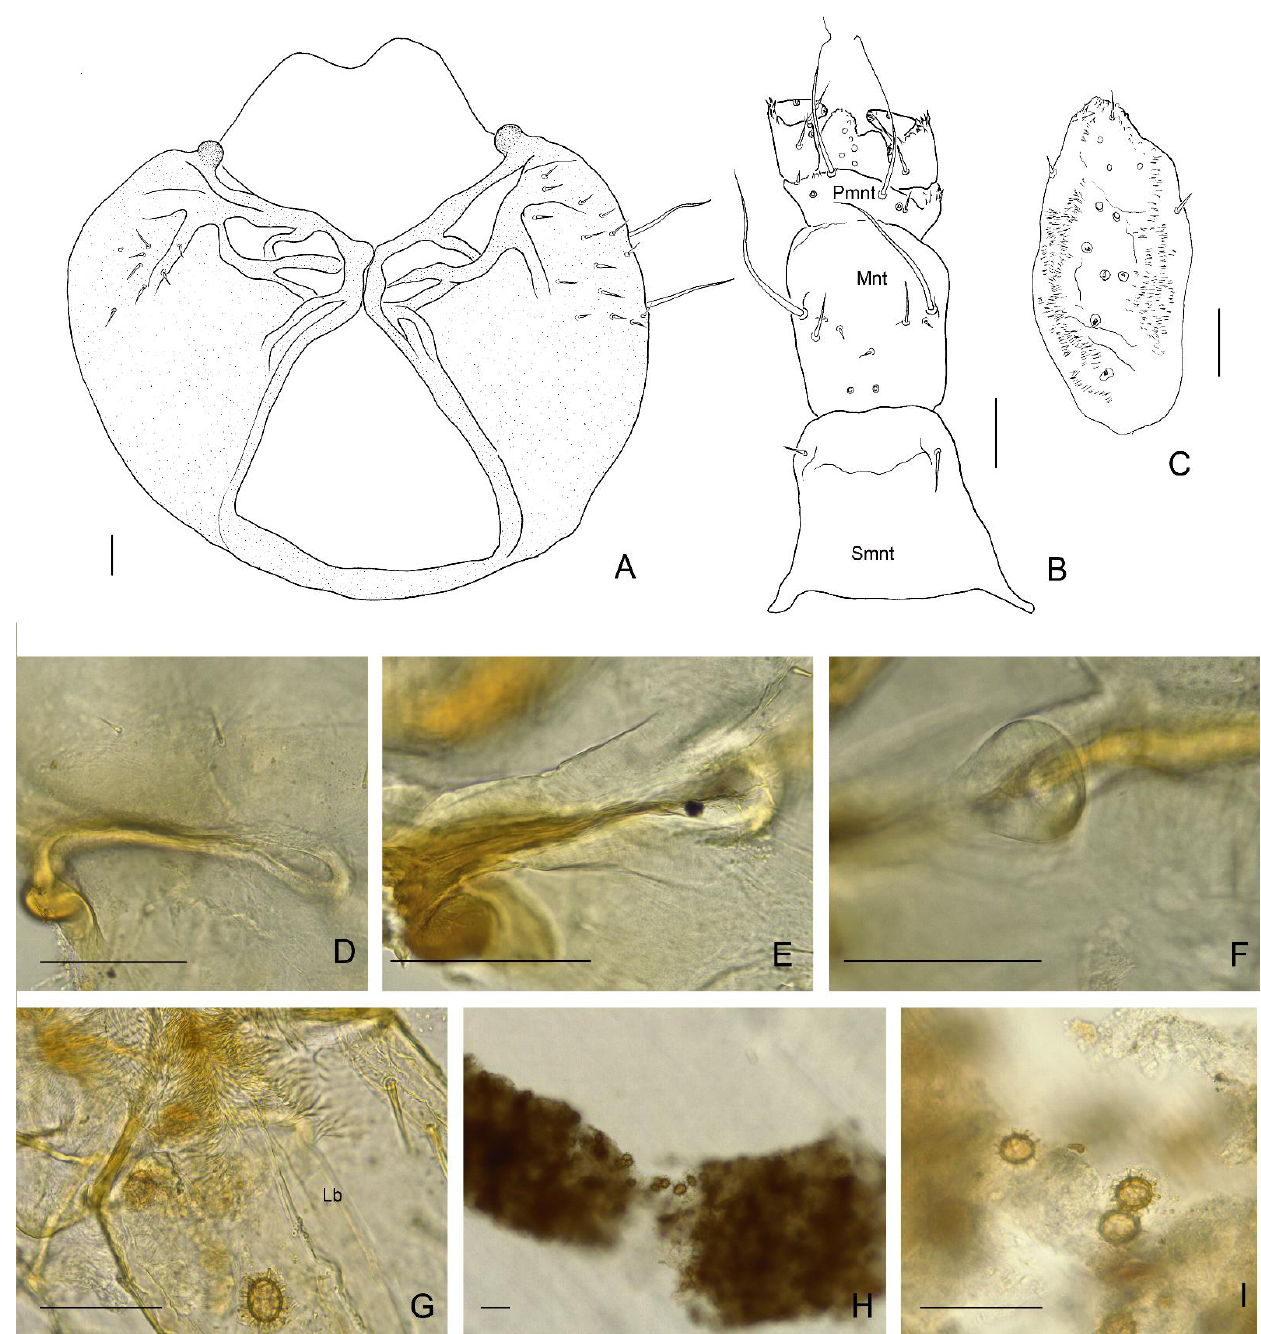
Figure 8. Leiodes cinnamomea . Details of larval morphology of instar III. ( A ) Head, ventral view. ( B ) Labium, dorsal side. ( C ) Epipharynx. ( D – F ) Head, invagination-pseudomycangia. ( G – I ) spores of Tuber aestivum ; ( G ) on way to alimentary canal—labrum ( H , I ) in alimentary canal. Abbreviations: Lb—labrum; Mnt—mentum; Pmnt—prementum; Sbmnt—submentum. Scale bars for A–I = 0.1 mm.